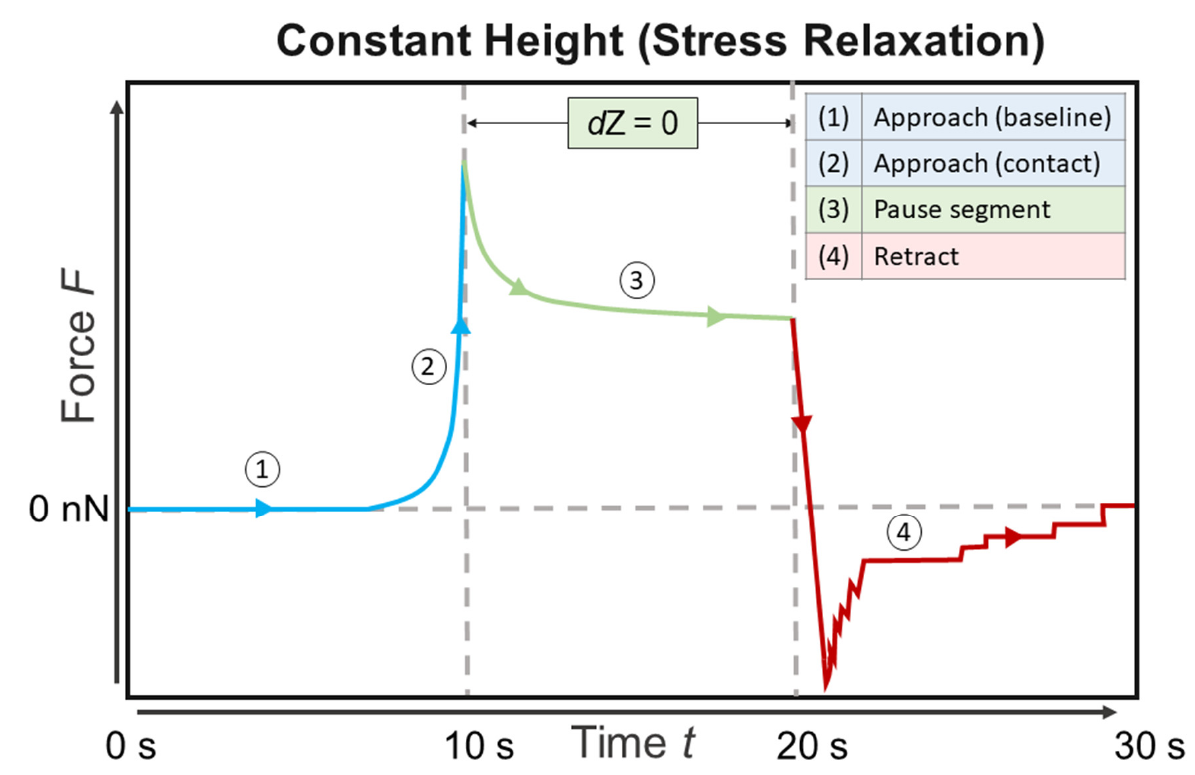
Figure 1. Schematic drawing of a force-time curve showing a stress relaxation experiment as performed in the atomic force microscopy (AFM) measurements.